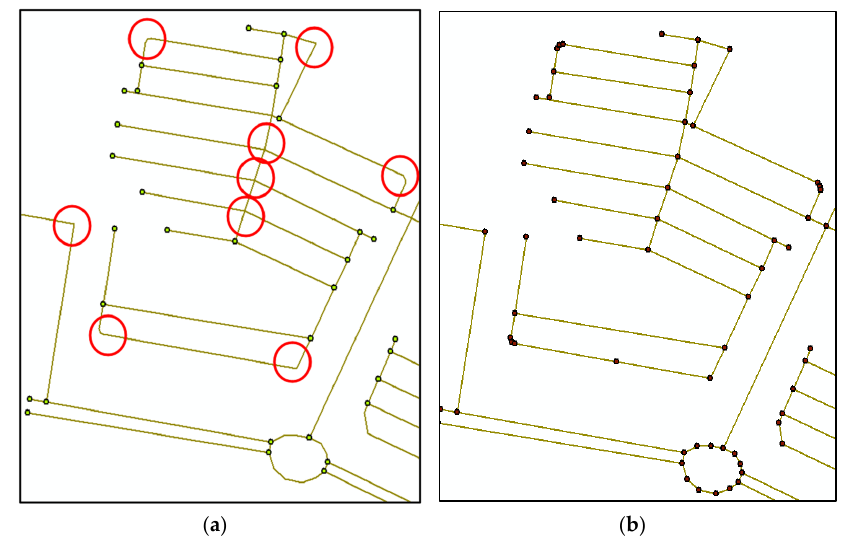
Figure 8. Differences between ( a ) before and ( b ) after split line at vertices